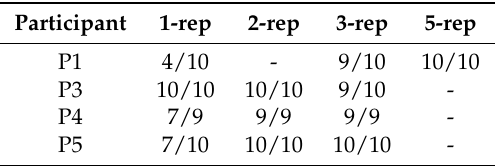
Table 6. Recognized exercises in the 1-2-3 scheme workouts. P1 performed the workout with a 1-3-5